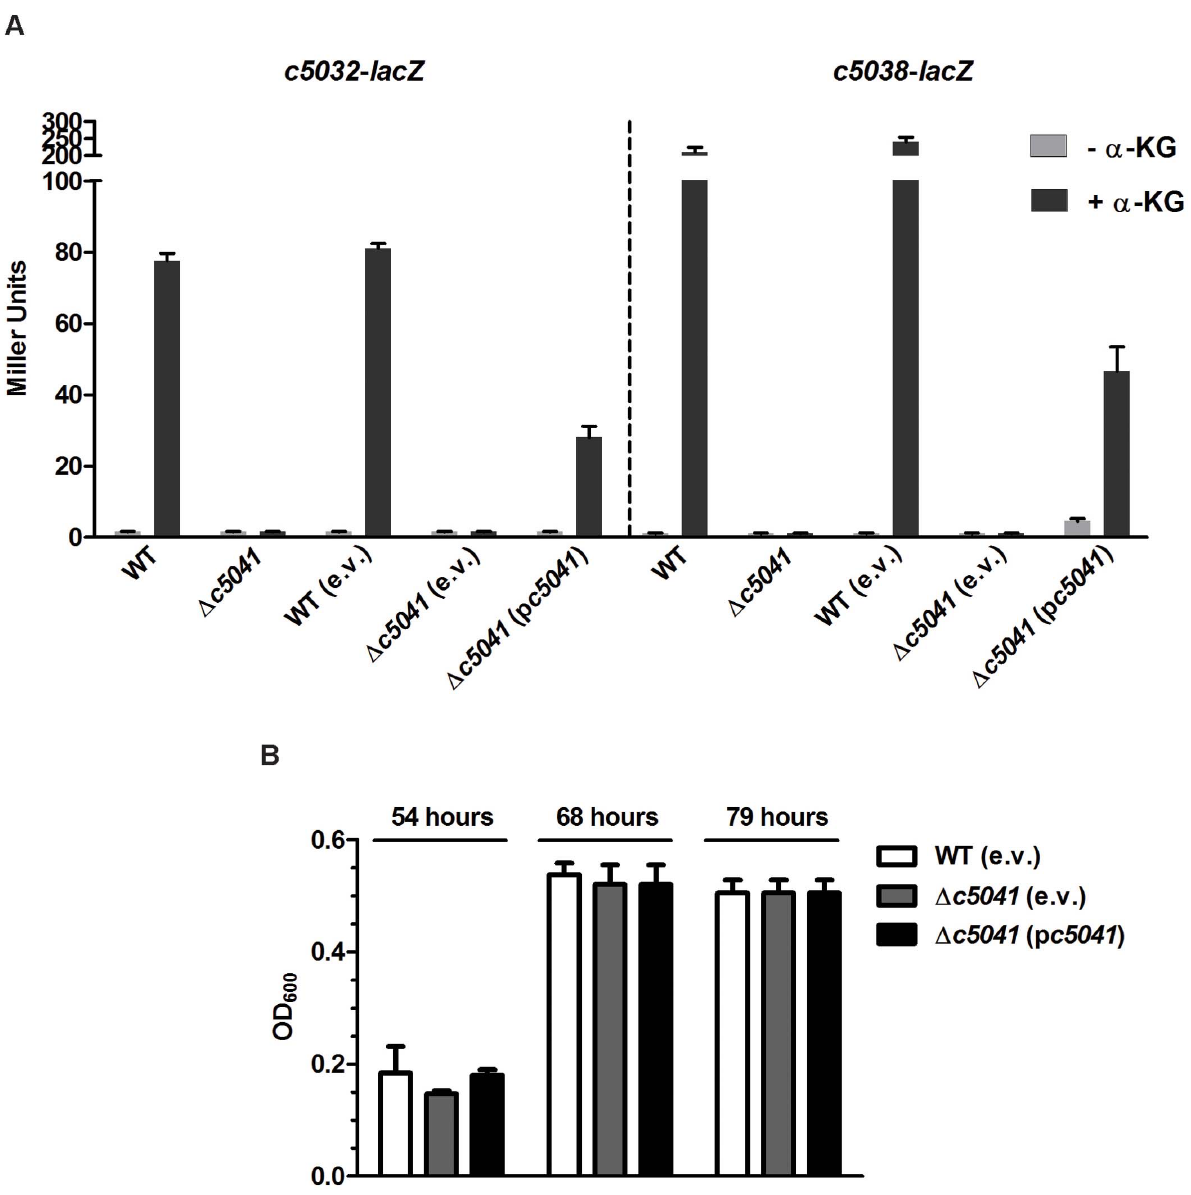
Figure 7. The role of c5041 . (A) Effects of c5041 on the expression of the target genes in response to a -KG. The expression of c5032 - lacZ or c5038 - lacZ in the WT, D c5041 (LMP106), and the complemented strains were represented by the b -galactosidase activity. (B) In vitro growth of D c5041 mutants. Optical density of CFT073 WT, D c5041 mutant, and the complemented strain during growth in M9 medium containing a -KG as the sole carbon source under anaerobic conditions was measured. Growth bars represent the average measurement at each time point from triplicate experiments.